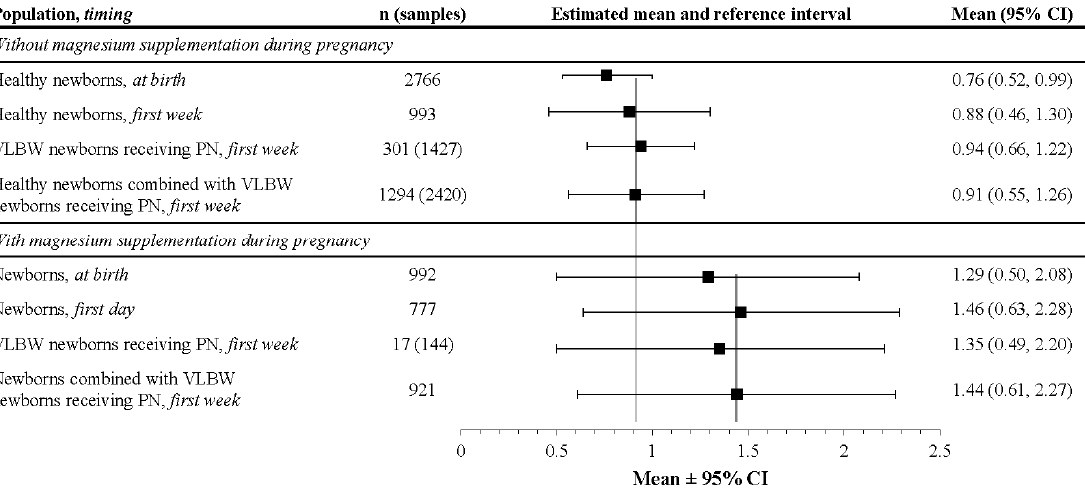
Figure 7. Summary of meta-analysis results of magnesium concentrations in newborns (mmol/L).